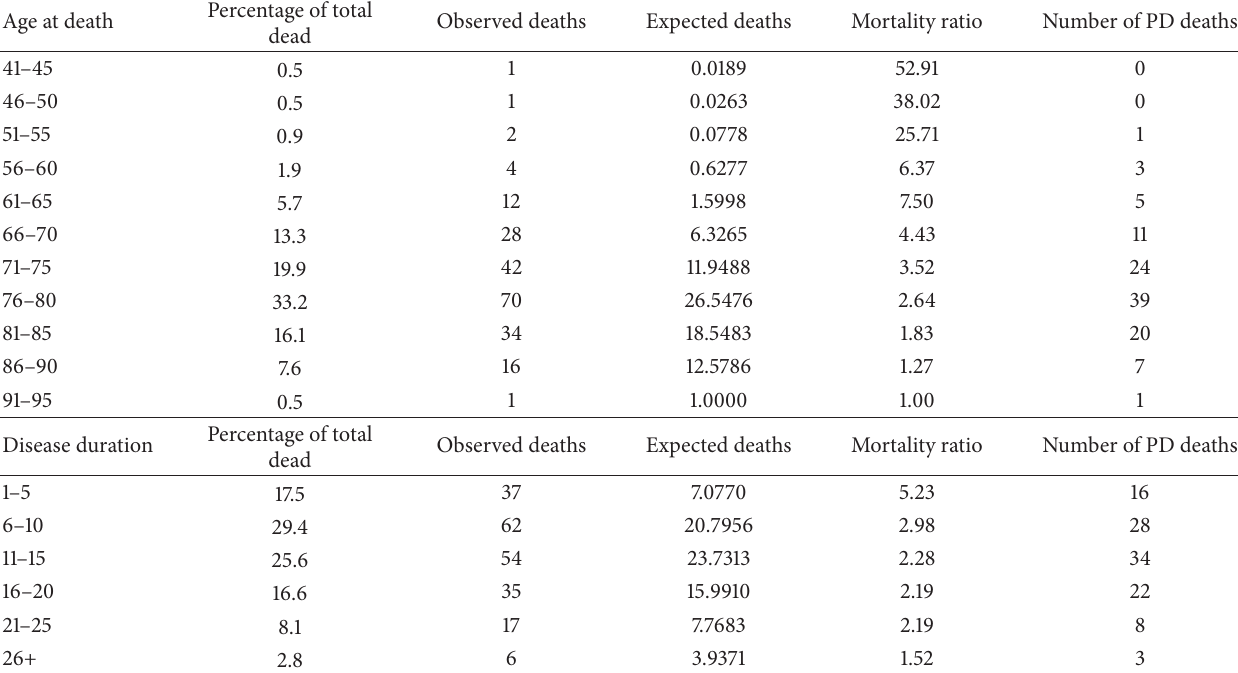
Table 4: Mortality in PD patients stratified by age at death and disease duration.